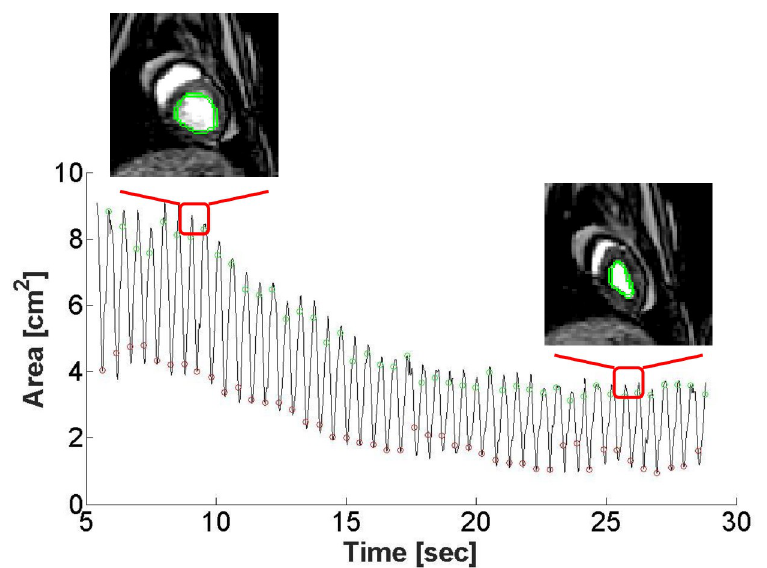
Fig 4. LV Area plot calculated by the level set algorithm with representative midventricular short-axis images of the LV before VCO and during VCO starting at t = 10 sec. Green makers = end-diastole (ED), Red markers = end- systole